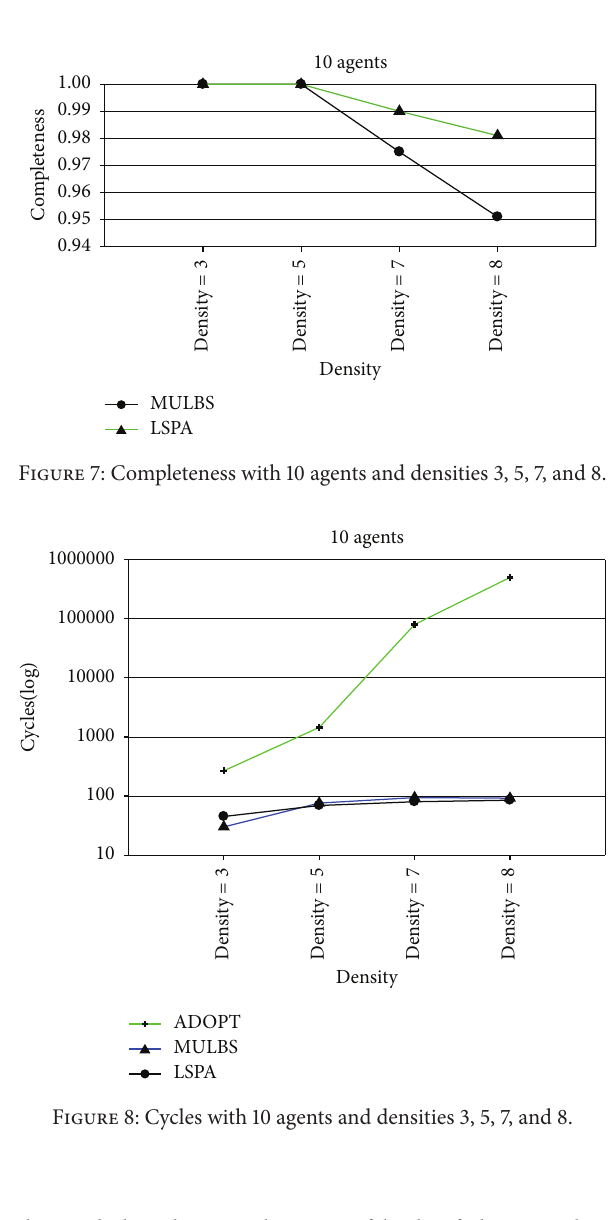
Figure 10: Messages with 10 agents and densities 3, 5, 7, and 8.